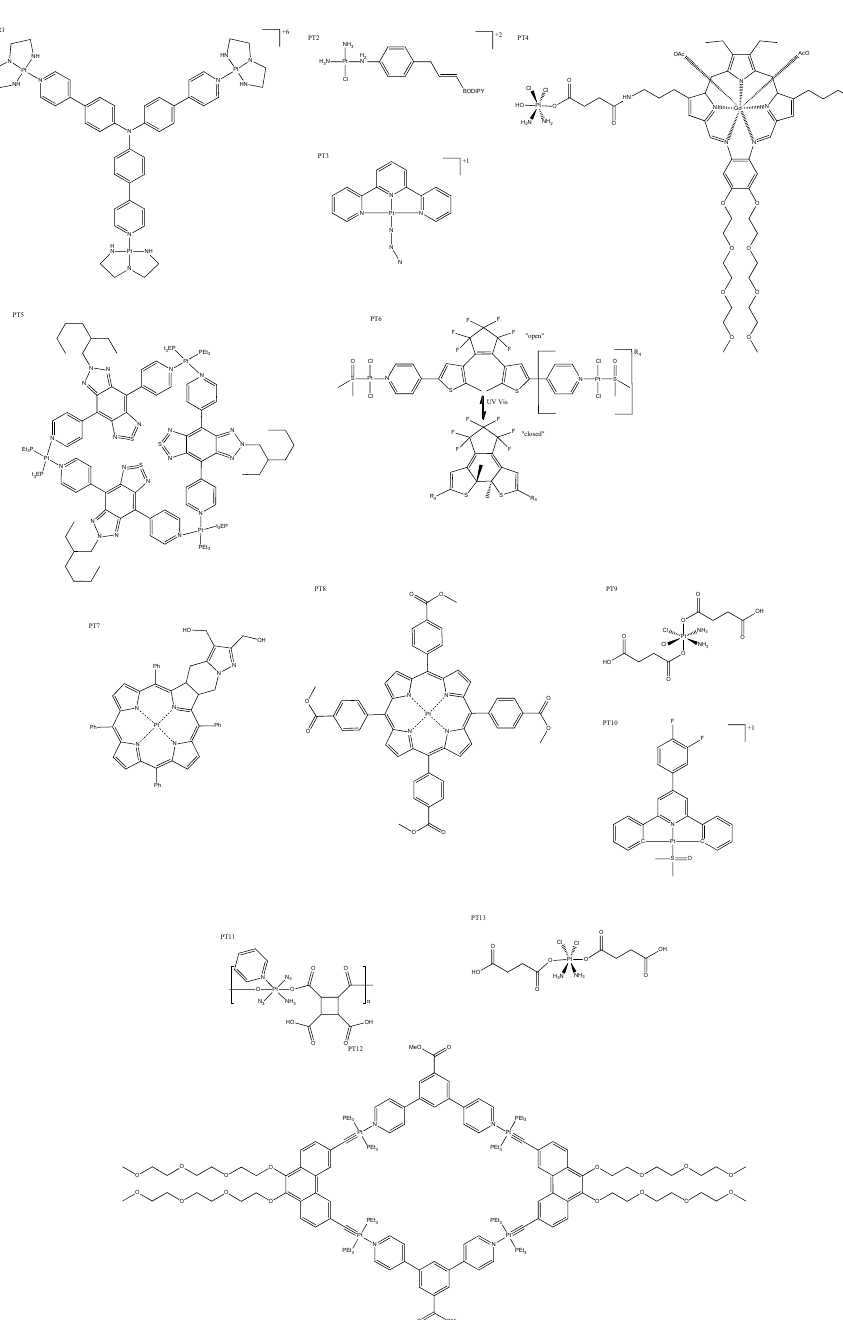
Figure 9. Photosensitizer platinum complexes: Y-shaped platinum complex PT1 [71]; square planar Pt(II) with weak photosensitizer, where BODIPY = boron–dipyrromethene, PT2 [72] and PT3 [73]; platinum–galadium complex PT4 [74]; triangular tri-platinum complex PT5 [75]; dual-platinum cen- ter Pt(II) diethienylcyclopentene PT6 in “open” and “closed” positions [76], PT7 [77], and PT8 [78]; platinum complexes (used to decorate a nanoparticle) PT9 [79] and PT10, [80]; platinum polymers PT11 [81] and PT12 [82]; and platinum complex (used as part of a nanoparticle) PT13 [83].